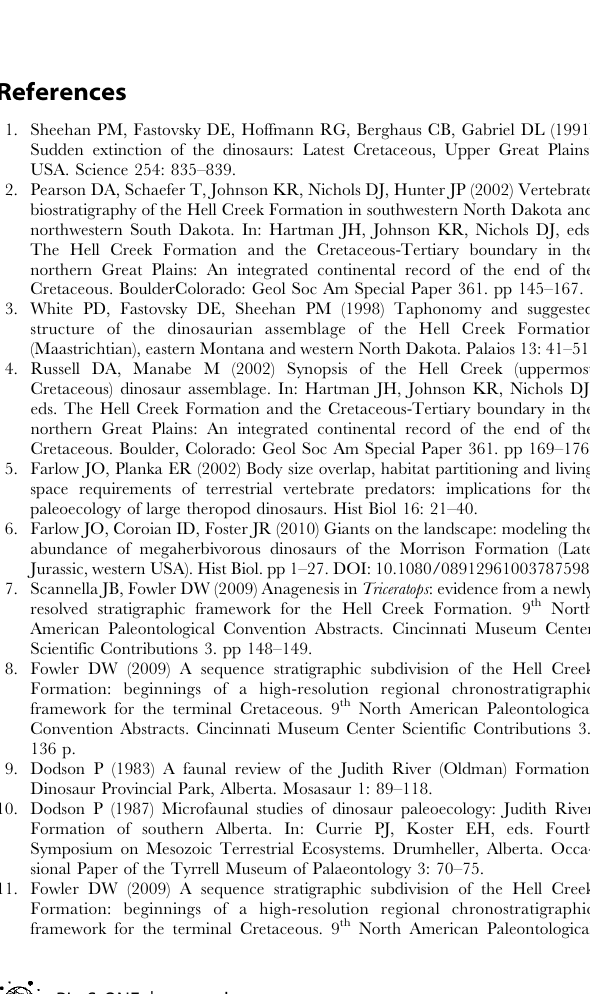
Table S1 Lower Hell Creek Formation (L3) dinosaur skeletons in order of abundance. Table S2 Upper Hell Creek Formation (U3) Triceratops skulls collected. These specimens are either whole skulls or isolated elements and do not qualify to be counted under the ‘‘three bone rule.’’ Table S3 Dinosaur census from 3B1 lag deposit (MOR loc. HC-312) at the base of the Jen-rex sand in order of abundance. Table S4 Upper Hell Creek Formation (U3) skeletons in order of abundance. (DOC) Table S5 Upper Hell Creek Formation (U3) Triceratops skulls recorded but not collected. Table S6 Census from the Doldrum’s lag deposit (MOR loc. HC-530) at the base of the Apex sandstone in the upper Hell Creek Formation (U3.AS) in order of abundance.